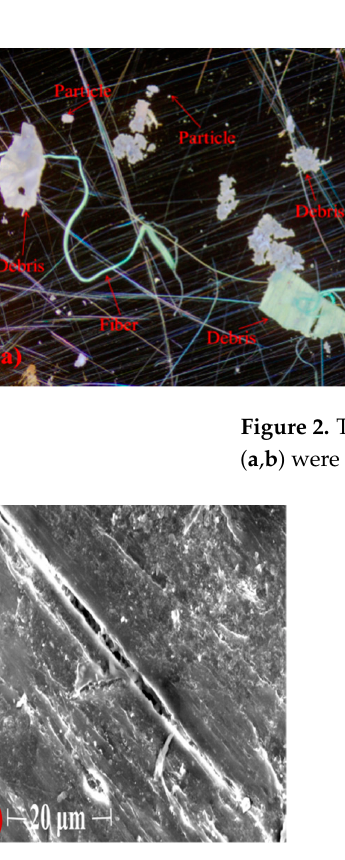
Figure 3. Photographs of selected microplastics (particle ( a ), debris ( b ), fiber ( c )) under SEM. ( a ), ( b ), and ( c ) were chosen under a stereomicroscope.